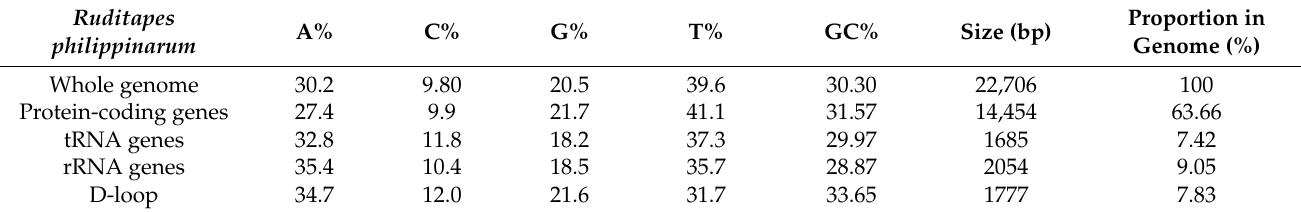
Table 4. Genomic features of Ruditapes philippinarum